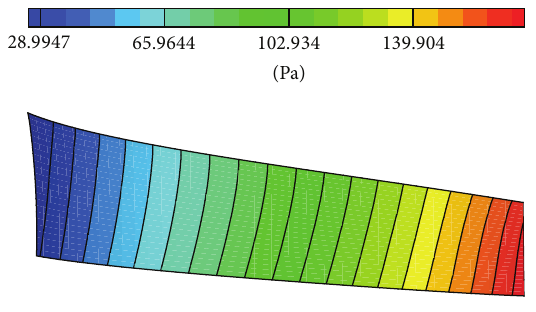
Figure 4: Pressure distribution.